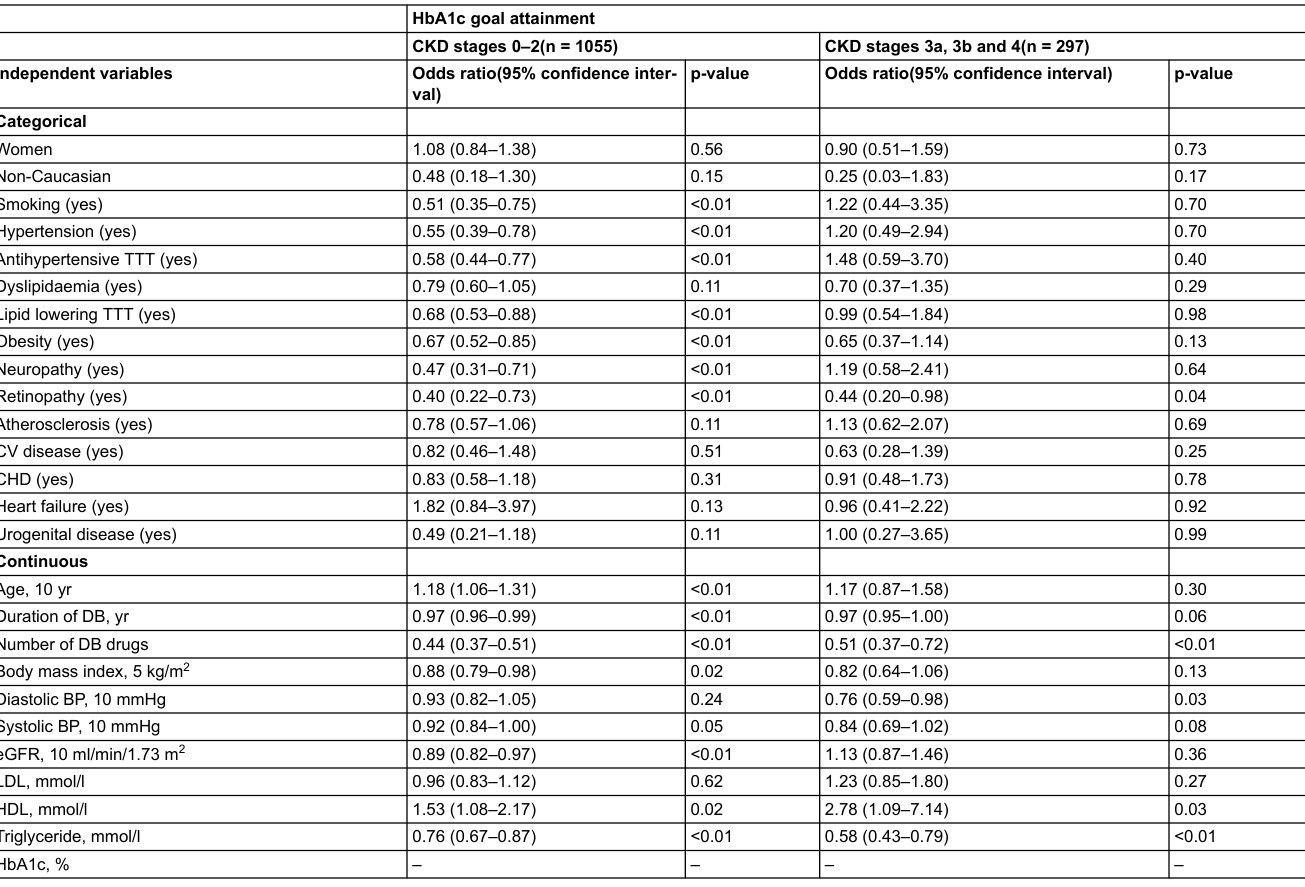
Table 3: Odd ratios for glycated haemoglobin goal attainment in univariate analysis (n =